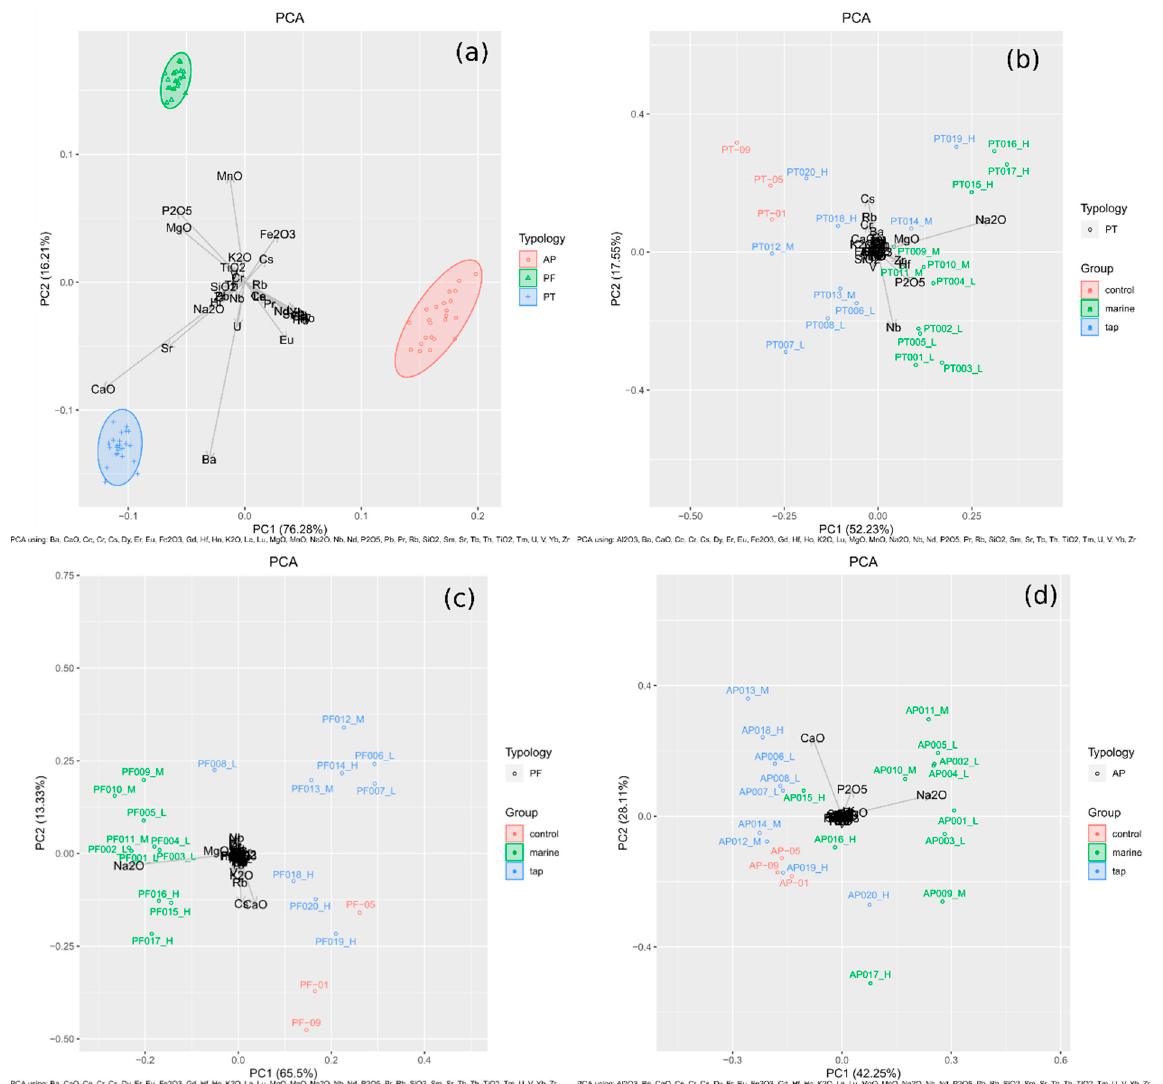
Figure 3. ( a ) Principal component analysis of 69 samples; ( b ) Principal component analysis of 23 PT samples; ( c ) Principal component analysis of 23 PF samples; ( d ) Principal component analysis of 23 AP samples. The four PCAs were calculated on the sub-composition of Al 2 O 3 , Ba, CaO, Ce, Cr, Cs, Dy, Er, Eu, Fe 2 O 3 , Gd, Hf, Ho, K 2 O, La, Lu, MgO, MnO, Na 2 O, Nb, Nd, P 2 O 5 , Pb, Pr, Rb, SiO 2 , Sm, Sn, Sr, Tb, Th, TiO 2 , Tm, U, V, Yb and Zr, but not for B and C, Pb was omitted also.